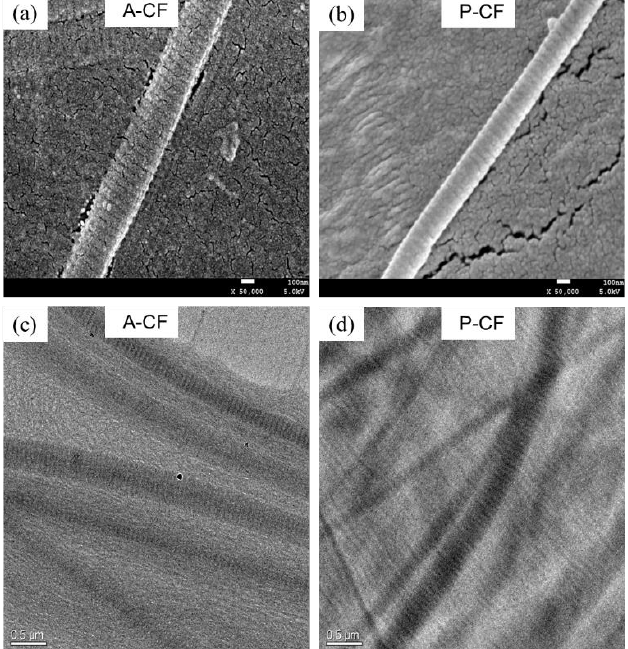
Figure 6. Microstructures of A-CF and P-CF. ( a , b ) SEM images of individual collagen fibrils. ( c , d ) TEM images of collagen fibrils dispersed in solution at the concentration of 60 µg/mL.